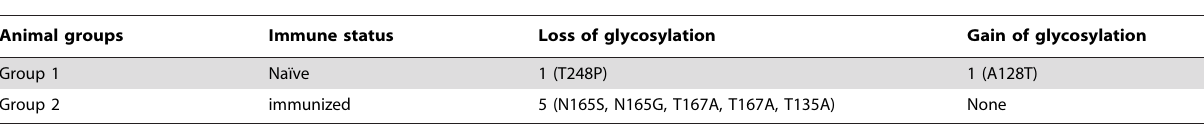
Table 3. Analysis of amino acid substitutions in HA variants.